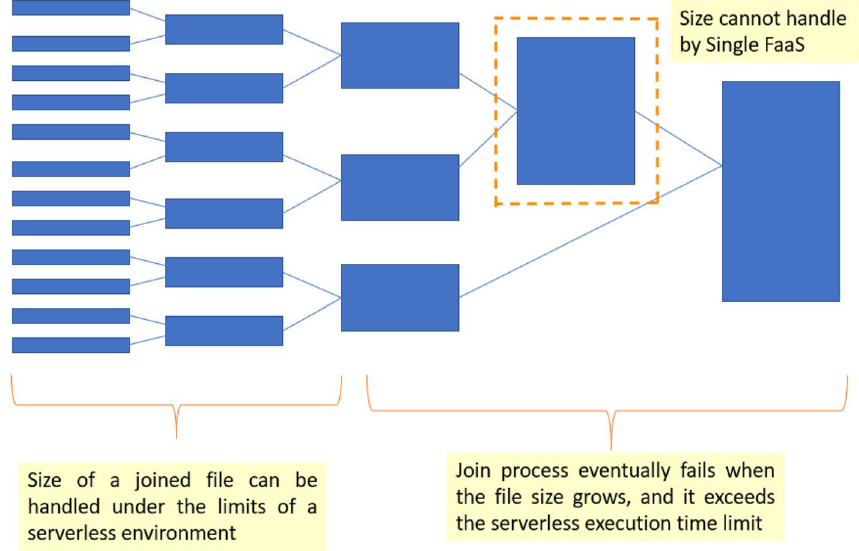
Fig. 5 Conventional method to join N files in